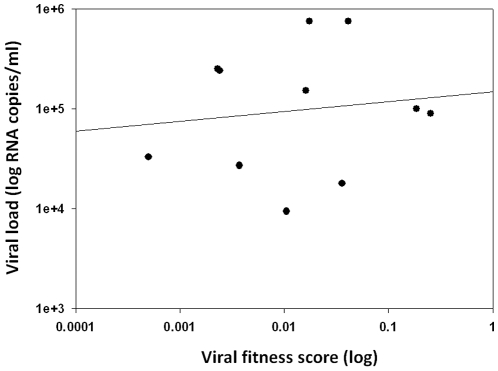
Viral fitness did not correlate with VL following analysis of isolates obtained from early chronic HIV-1 infection subjects.Coincident plasma VL measurements (log10 RNA copies/ml) were plotted against relative viral fitness scores (log10) for 16 isolates, obtained from plasma, from PHAEDRA subjects. The Pearson correlation was rho = 0.133, p = 0.697.